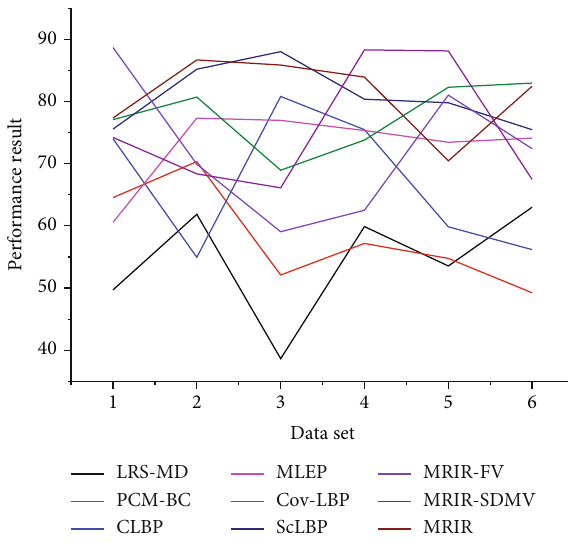
4: Performance experimental comparison